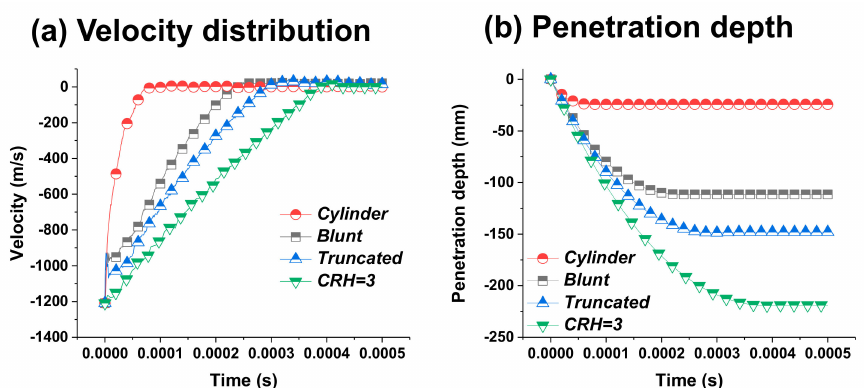
Figure 12. Velocity and penetration depth with respect to time: ( a ) Velocity distribution and ( b ) Penetration depth.